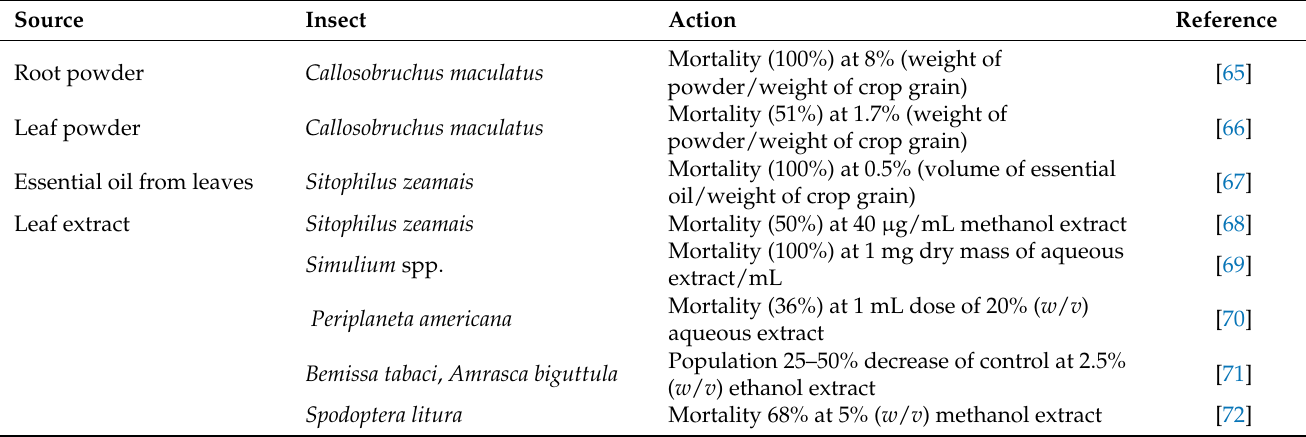
Table 1. Interaction of C. odorata with insects.